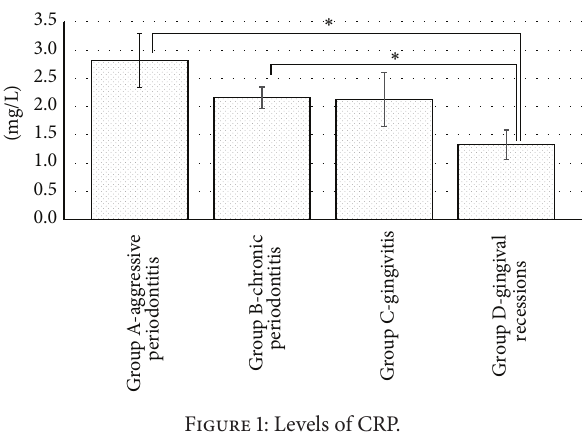
Figure 1: Levels of